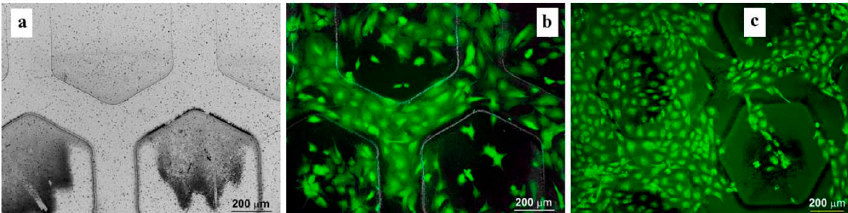
Figure 11. Optical micrographs of two cell lines on the surface of a polyimide sample with carbon